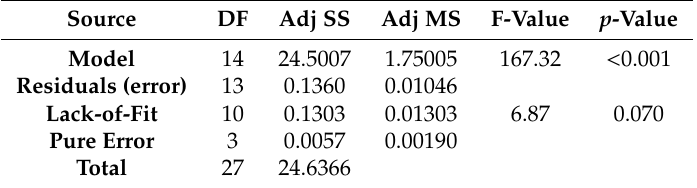
Table 7. Analysis of Variance was used to confirm the adequacy of the model used in this study.